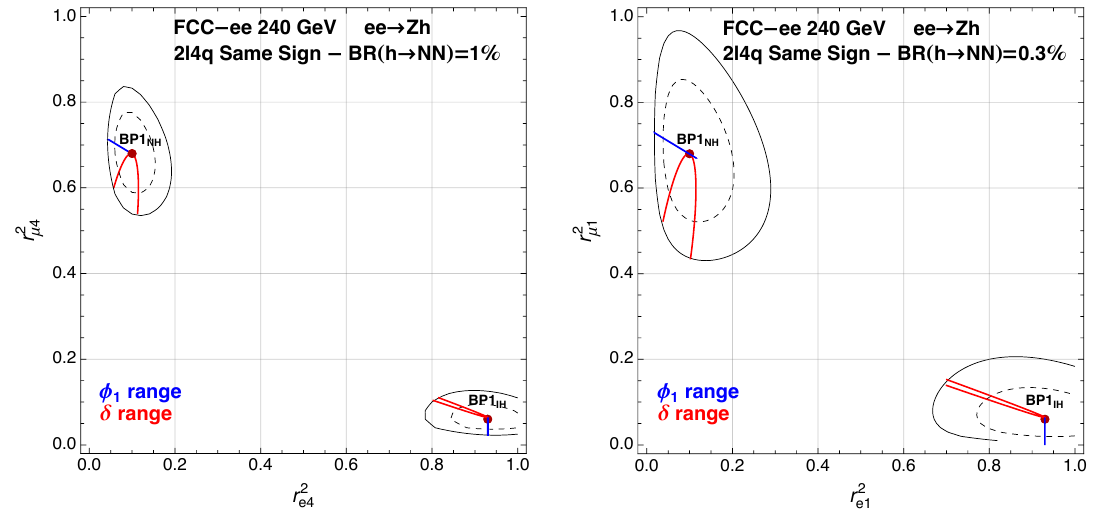
Figure 6 . 68% (dashed) and 95% (solid) confidence intervals for determining the flavor structure of a putative BSM signal observed associated with BP1 NH and BP1 IH in the 2 ‘ 4 q final state with a pair of SS leptons. We fix BR( h → NN ) = 1% (left), 0 . 3% (right) and m N = 30 GeV. 2 ‘ 4 q final state with a pair of SS leptons, a representative RH neutrino mass of 30